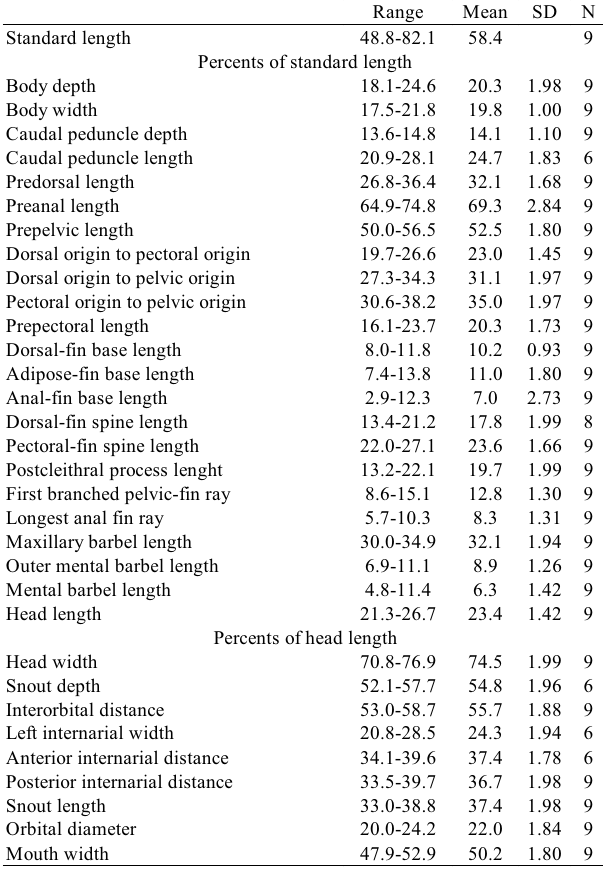
Table 11. Morphometric data for Tatia neivai . SD = standard